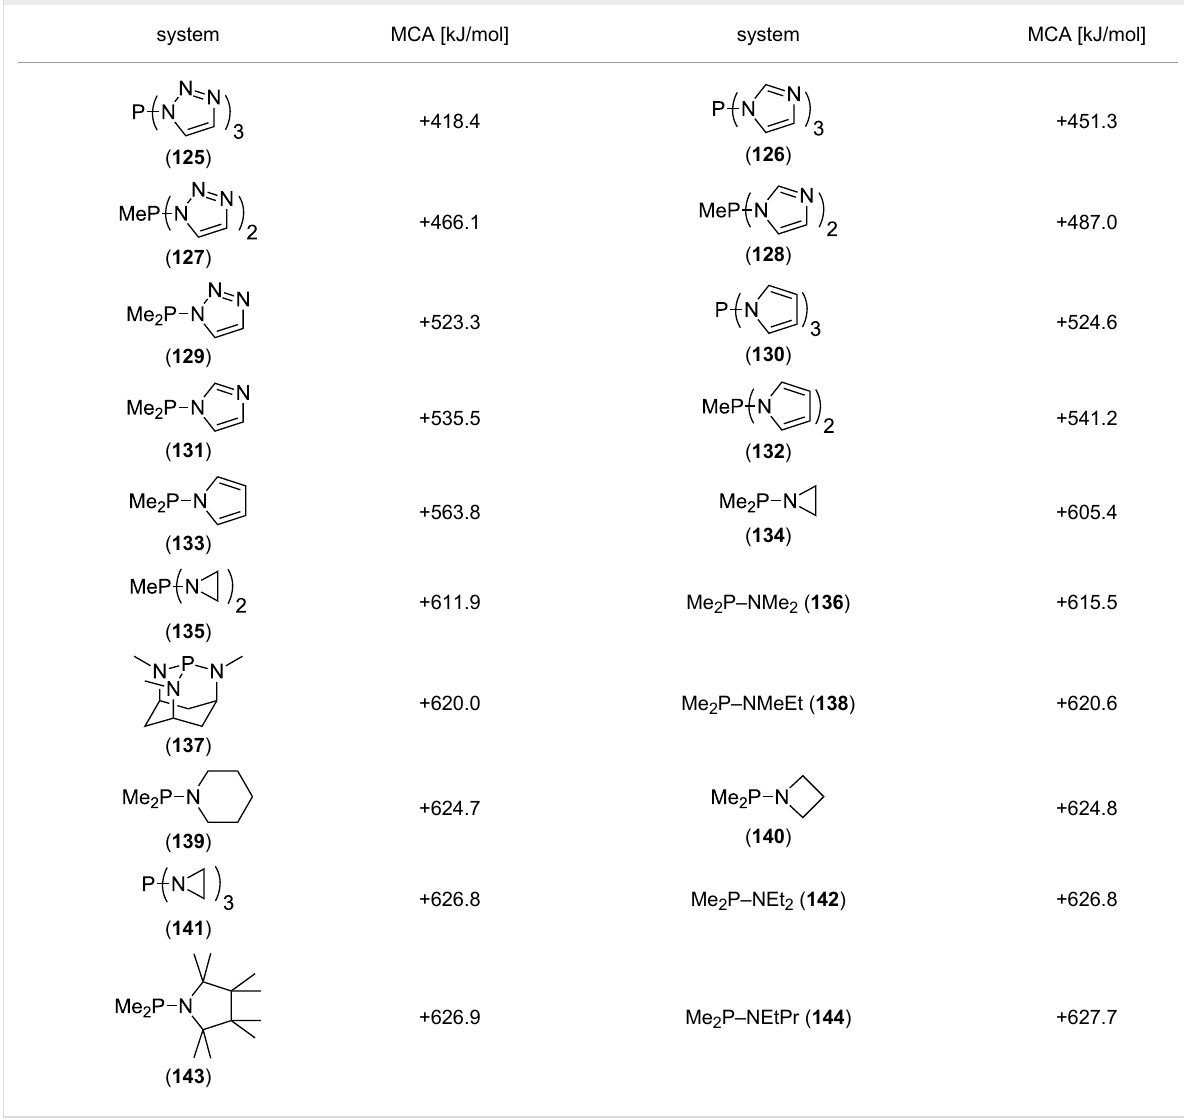
Table 3: MCA values of phosphanes containing one to three P–N bonds, ordered by increasing MCA